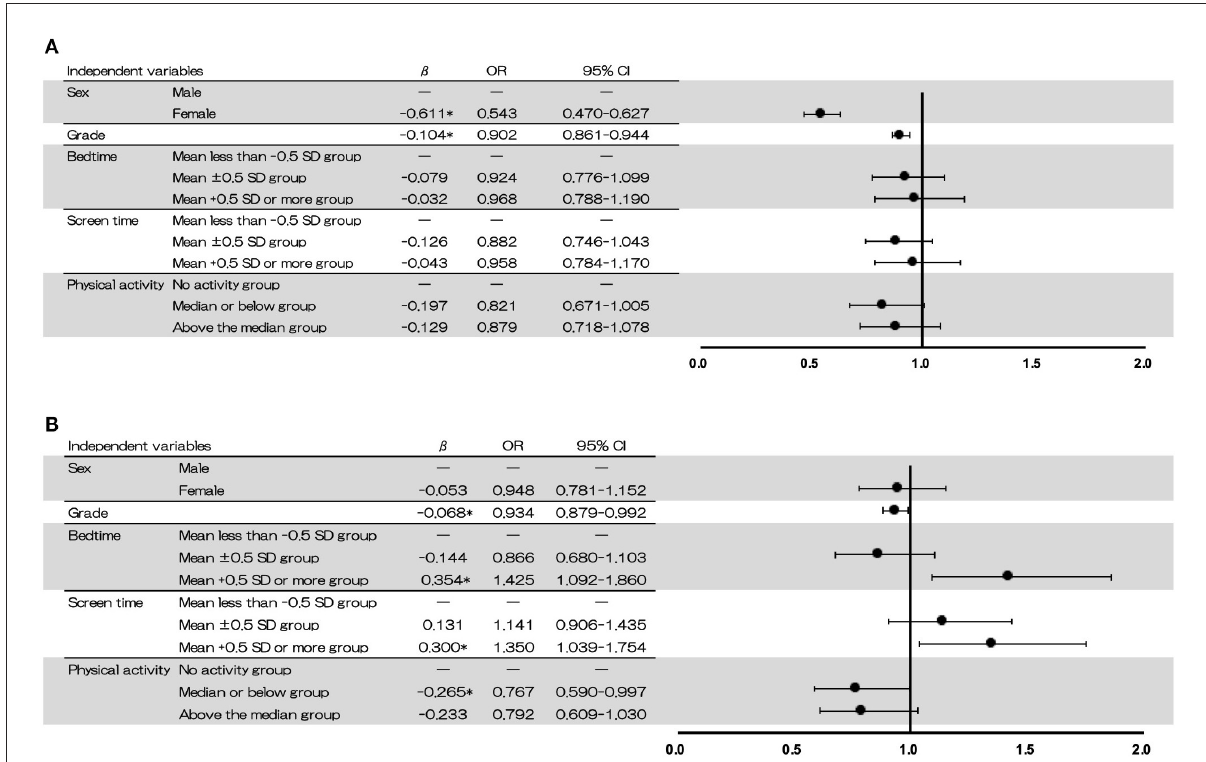
FIGURE4 Relationship between lifestyle behaviours and commission errors (A) and omission errors (B). The results were analysed using the data from 3rd grade of elementary school to 3rd grade of junior high school ( n = 3,217). β = standardised partial regression coefficient, OR, odds ratio, 95% CI, 95% confidence